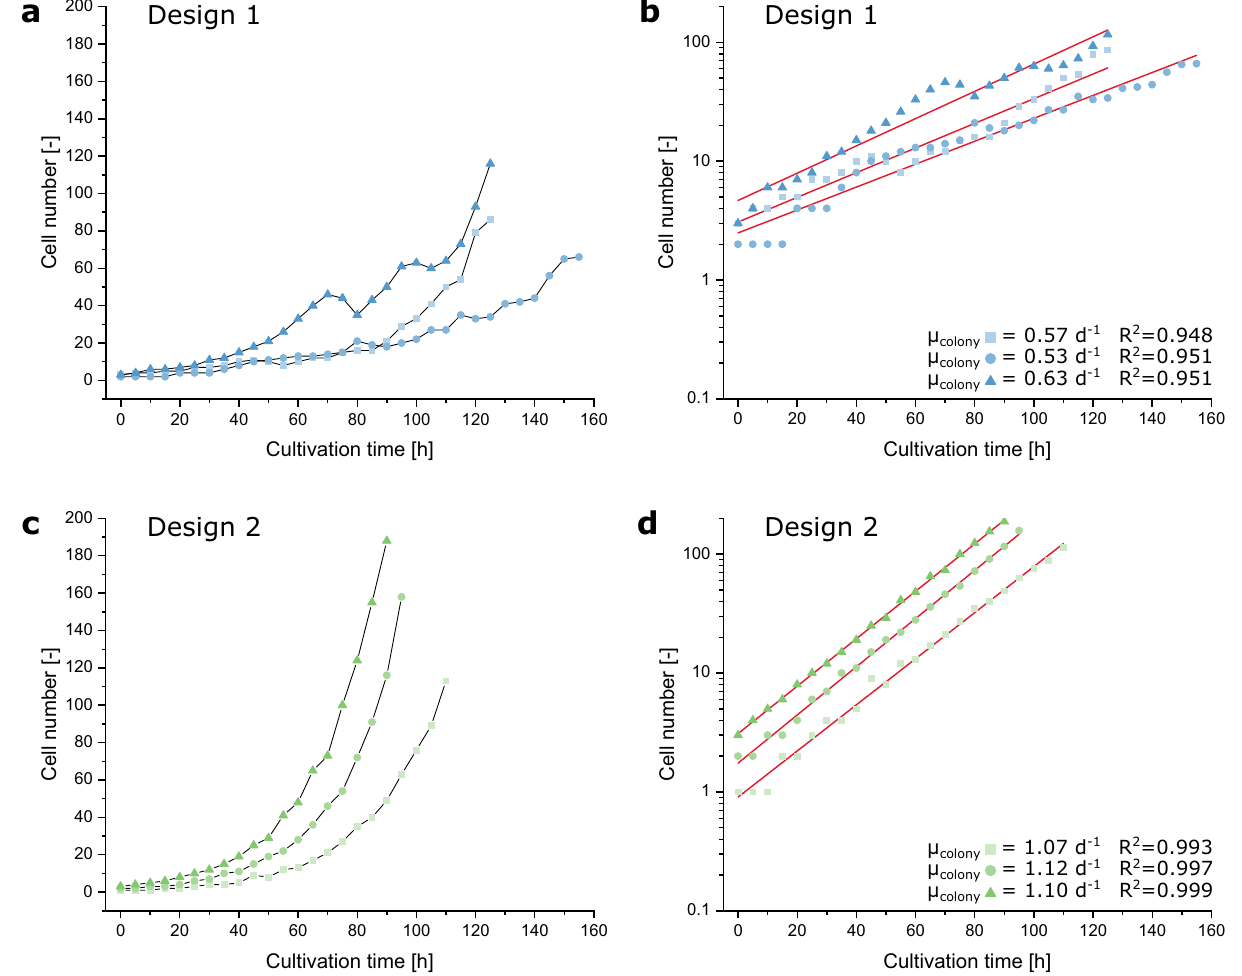
Figure 3. MSCC of CHO cells and cell retention assessment of the MSCC designs. ( a ) Growth of three CHO-K1 microcolonies from three individual cultivation arrays cultivated applying Design 1. ( b ) Semi- logarithmically plotted growth profile of the microcolonies cultivated applying Design 1. ( c ) Growth of three CHO-K1 microcolonies from two individual cultivation arrays cultivated applying Design 2. ( d ) Semi- logarithmically plotted growth profile of the microcolonies cultivated applying Design